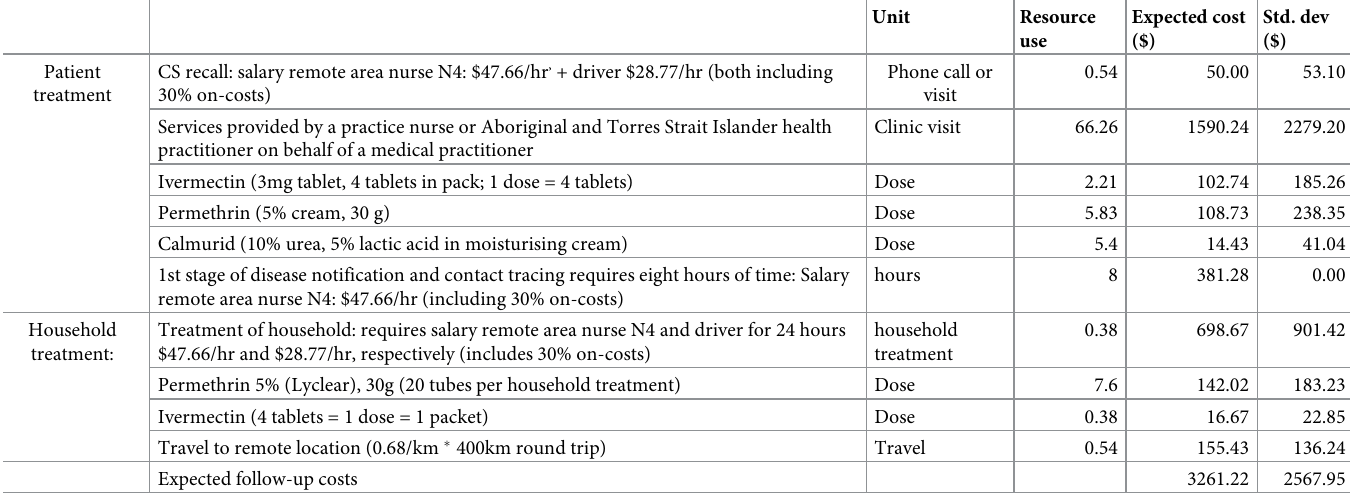
Table 7. Resource use and expected cost of the CS patient and community follow-up phase.